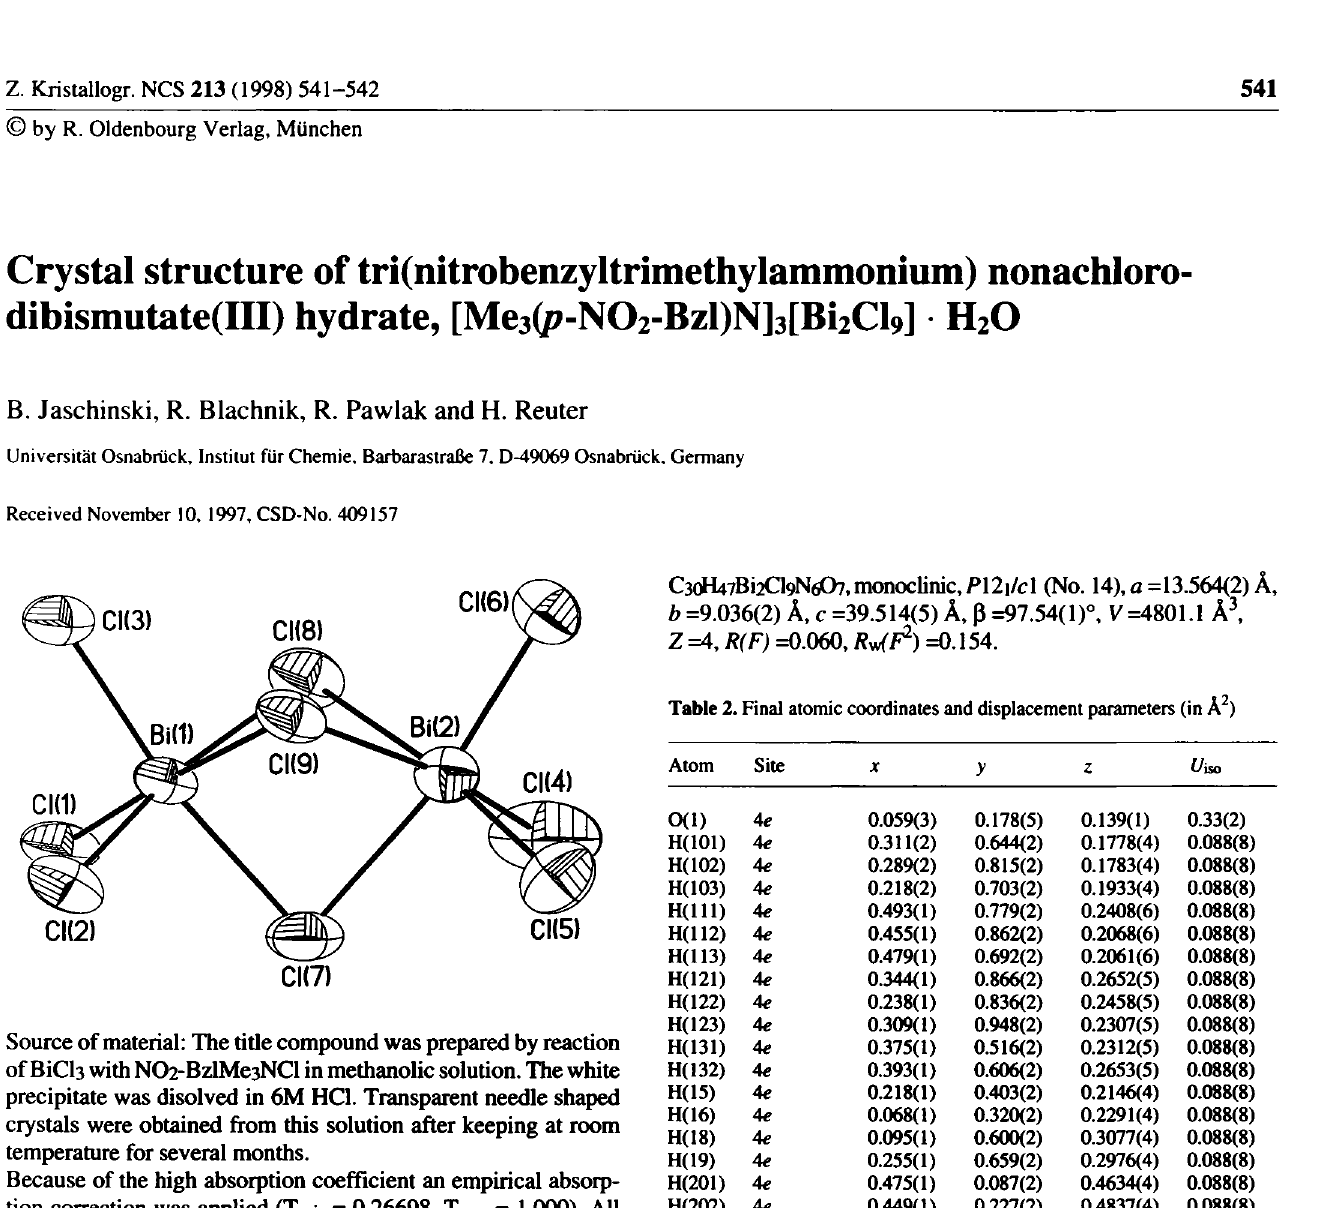
Table 1. Parameters used for the X-ray data collection Crystal: